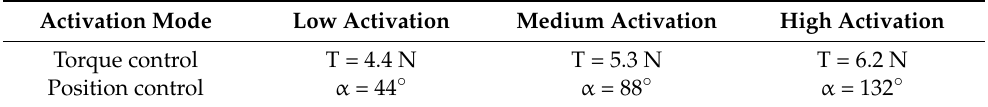
Table 5. Inputs used in positioning tests.